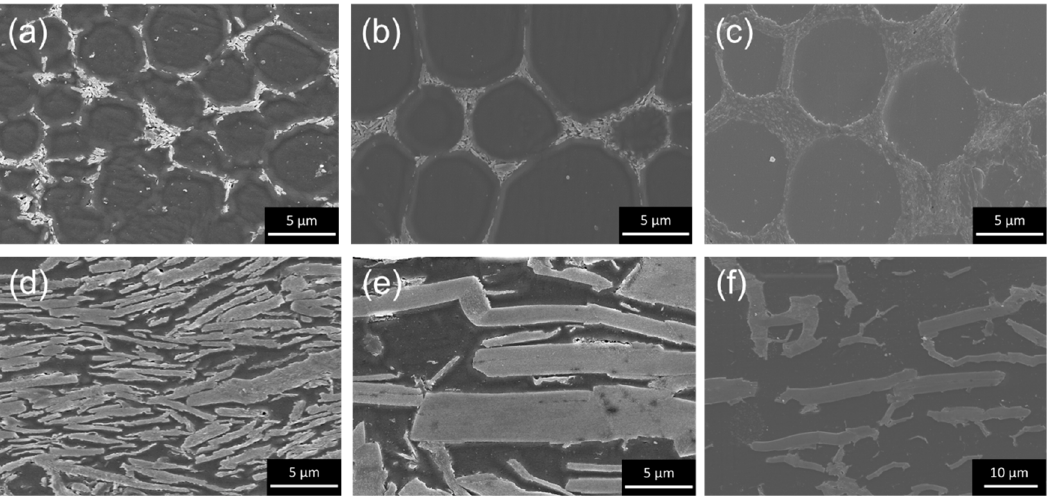
Figure 4. Cross-sectional SEM images of the respective hBN/PMMA composite pellets obtained after hot-pressing, using the following composite powders: ( a ) 0.5-µm hBN on 5-µm PMMA, ( b ) 0.5-µm hBN on 12-µm PMMA, ( c ) 5-µm hBN on 12-µm PMMA, ( d ) 0.3-µm PMMA on 5-µm hBN sheets, ( e ) 0.3-µm PMMA on 18-µm hBN sheets, and ( f ) 5-µm PMMA on 18-µm hBN sheets.